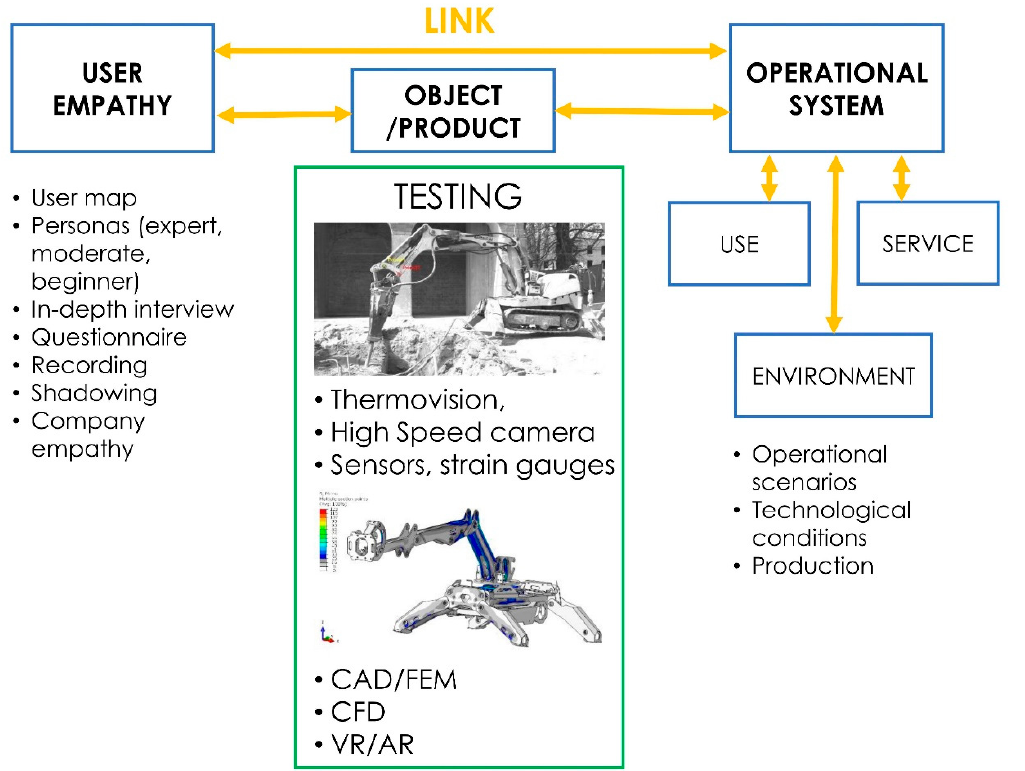
Figure 6. Link between the study of user needs (empathy stage) and the analysis of the operational system is a crucial step in proper project need/problem